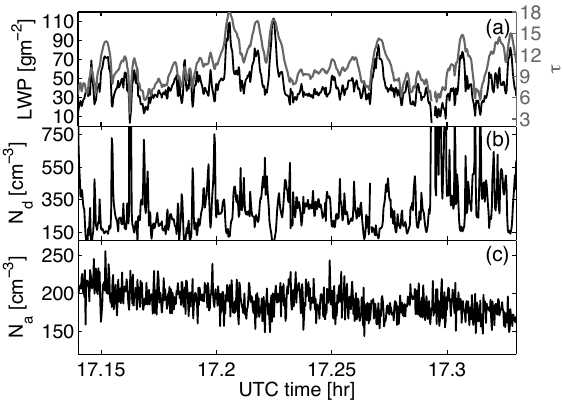
Figure 5: Example of time series during October 18 th research flight (RF02, subcloud leg 954 Fig. 5. Example of time series during 18 October research flight (RF02, subcloud leg 5): (a) GVR LWP (black) and τ (gray), (b) N d 5): a) GVR LWP (black) and τ (gray), b) N d from equation (9), c) accumulation mode 955 from Eq. (9), (c) accumulation mode aerosol concentration N a